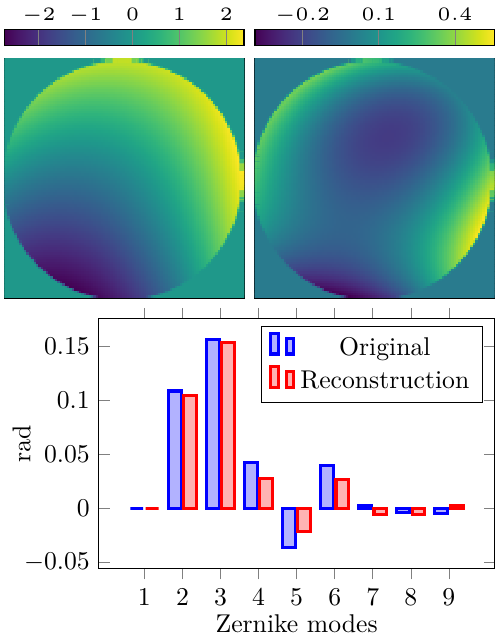
Figure 12. Top left: original phase; Top right: phase residual; Bottom: comparison of original and reconstructed Zernike coefficients using Noll’s index notation